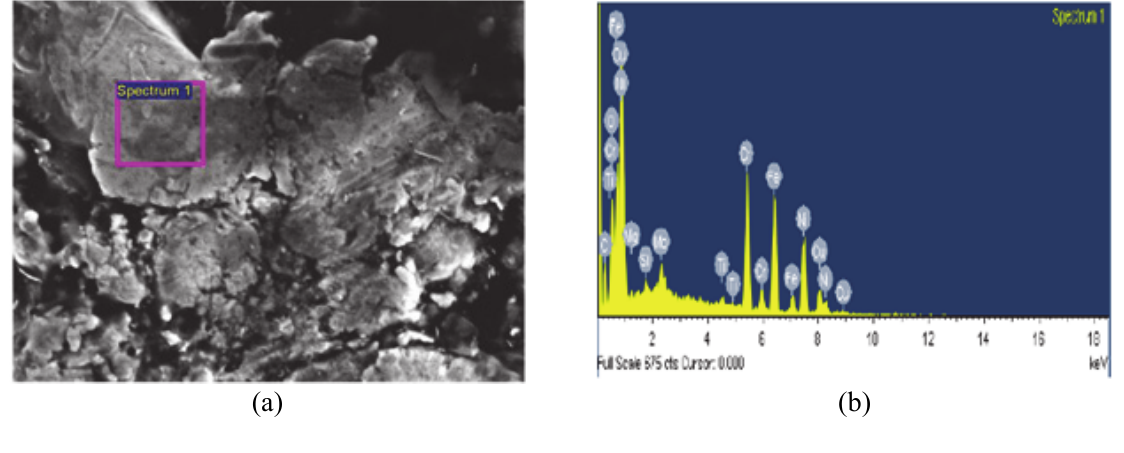
Fig. 5. EDX analysis of work specimen